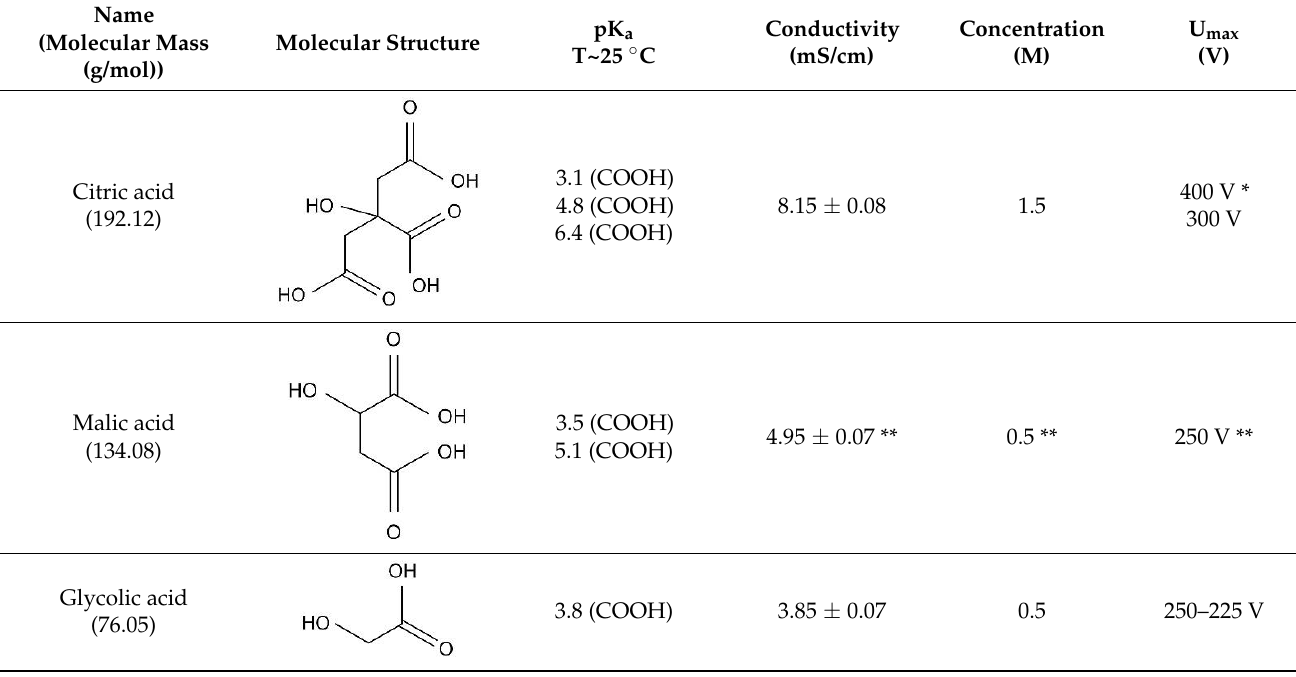
Table 5. Molecular mass and structure, dissociation constants pK a (acidity at T~25 °C) [23,29], and conductivity of α -hydroxy acids together with the concentration and U max applied during anodization of Al.